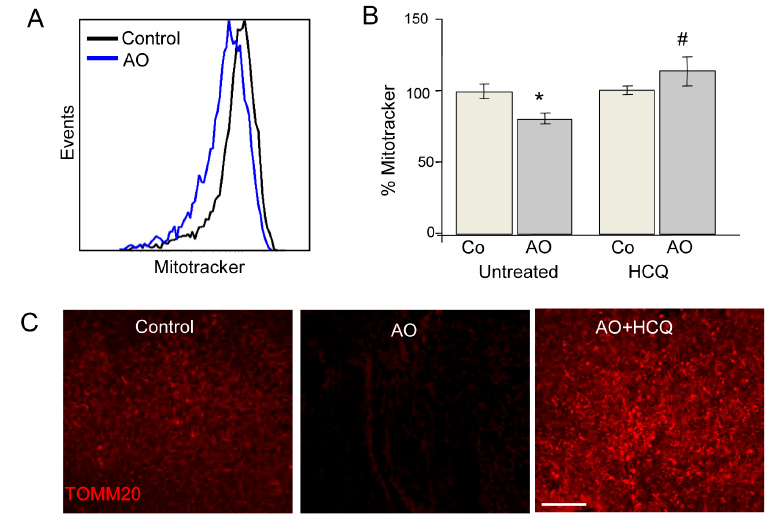
Figure 5. Mitophagy assessment in E13.5 embryonic retinas treated with AO. ( A ) Representative histogram of E13.5 retinas treated for 6 h with AO, dissociated, and stained with MTDR (Invitrogen, M22426) for flow cytometry analysis; ( B ) the percentage mean fluorescence intensity vs. control cells is shown. * p < 0.05 with respect to corresponding control group. # p < 0.05 with respect to corresponding group incubated in the absence of HCQ or CsA (untreated); and ( C ) TOMM20 staining in retinal flatmounts of E13.5 retinas cultured for 6 h and treated as indicated. Insets show the magnification of TOMM20. Scale bar is 50 µ